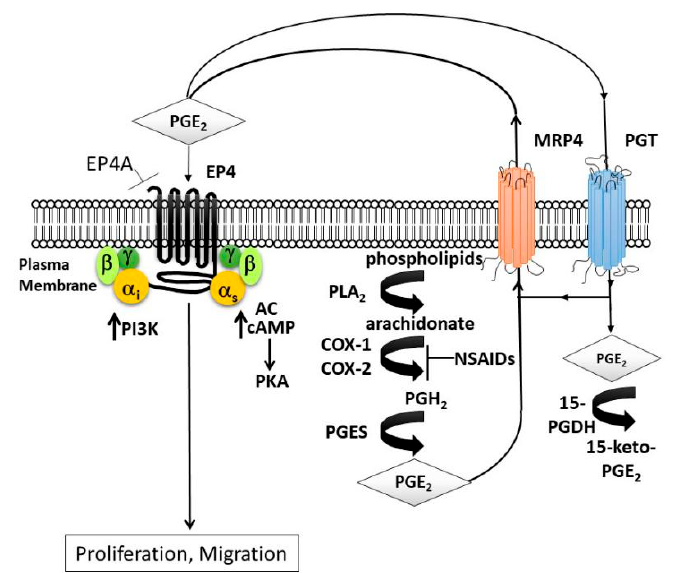
Figure 1. Prostaglandin signaling. Phospholipase A2 (PLA 2 ) converts phospholipids from the plasma membrane to arachidonate. Cyclooxygenase enzymes, (COX-1 or COX-2) catalyze arachidonate to prostaglandin H2 (PGH 2 ) followed by conversion to prostaglandin E2 (PGE 2 ) by PGE synthase. PGE